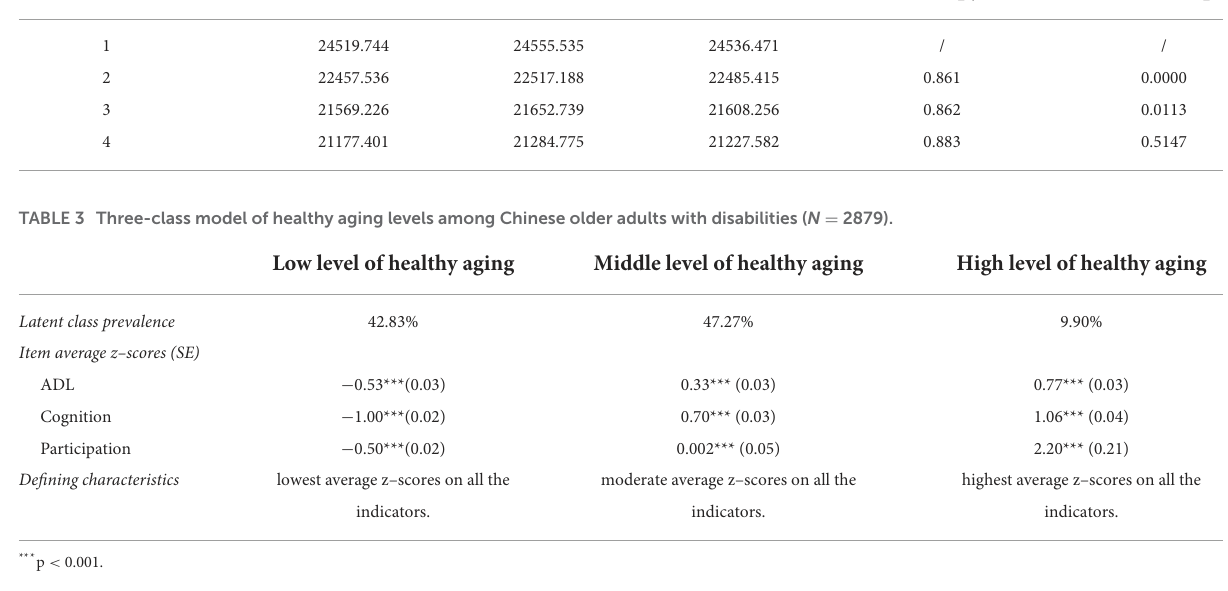
TABLE 2 Comparison of fit statistics for LPA models with one to four classes ( N = 2879). Number of Classes